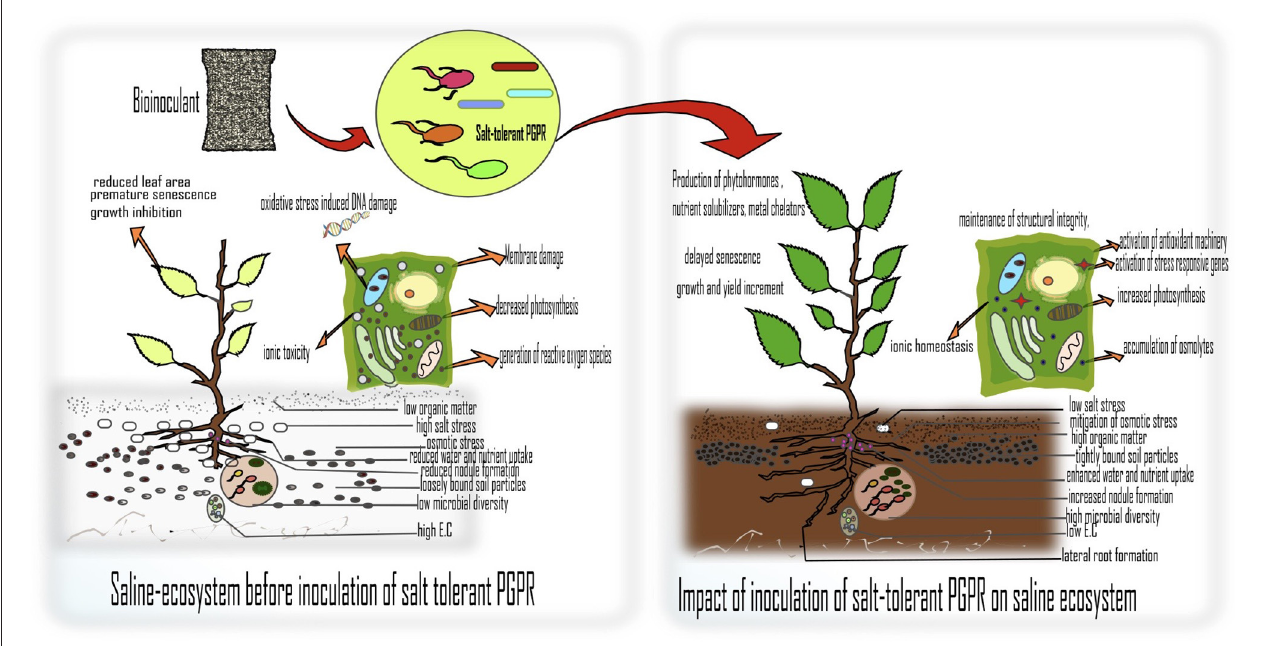
FIGURE 1 | Mechanisms of improving plant health and remediation of saline soils by inoculation of